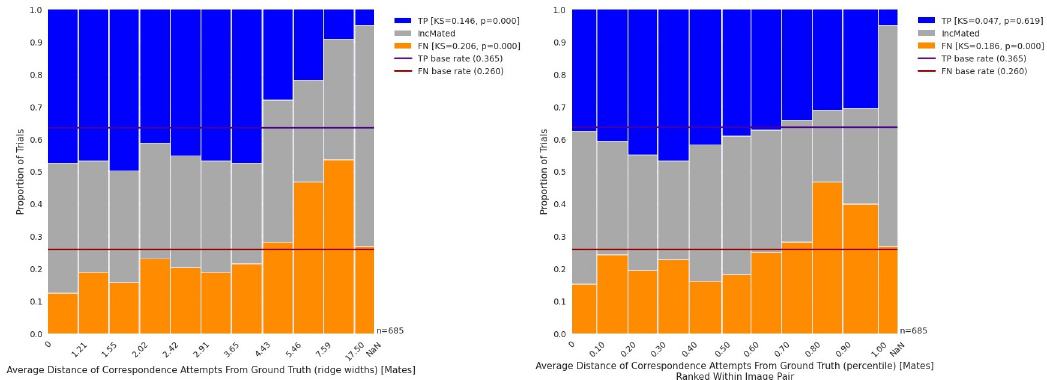
Fig 7. Distribution of outcomes by average distance of correspondence attempts. Left panel: Proportions of trials of TP, IncMated, and FN outcomes for different deciles of Average Distance of Correspondence Attempts. Right panel: Proportions of trials of TP, IncMated, and FN outcomes for different deciles of Average Distance of Correspondence Attempts, ranked within each image pair. NaN (not a number) values come from four mated image pairs for which we had no thin plate spline solution and could not compute